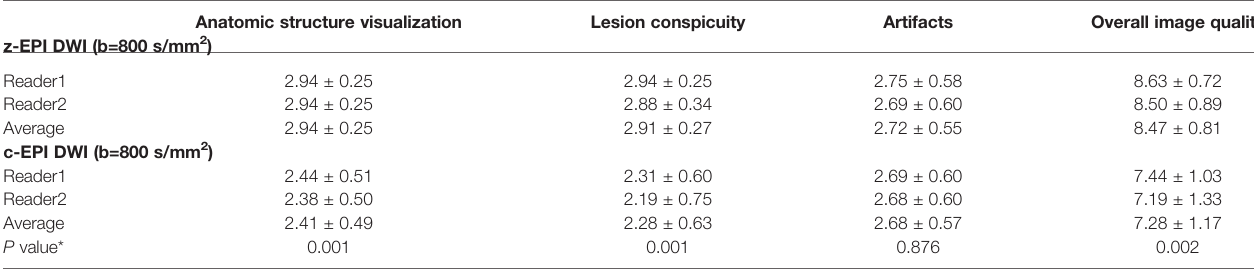
TABLE 2 | Image quality scores for the comparison of c-EPI DWI and z-EPI DWI. Anatomic structure visualization Lesion